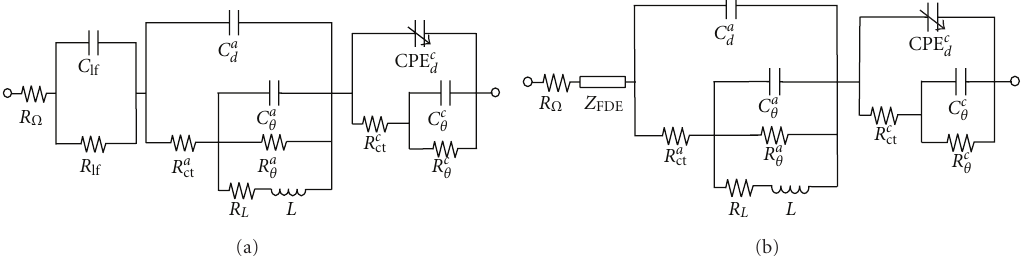
Figure 5: Equivalent circuit model for a total button cell consisting of the button cell anode and cathode equivalent circuits in series with